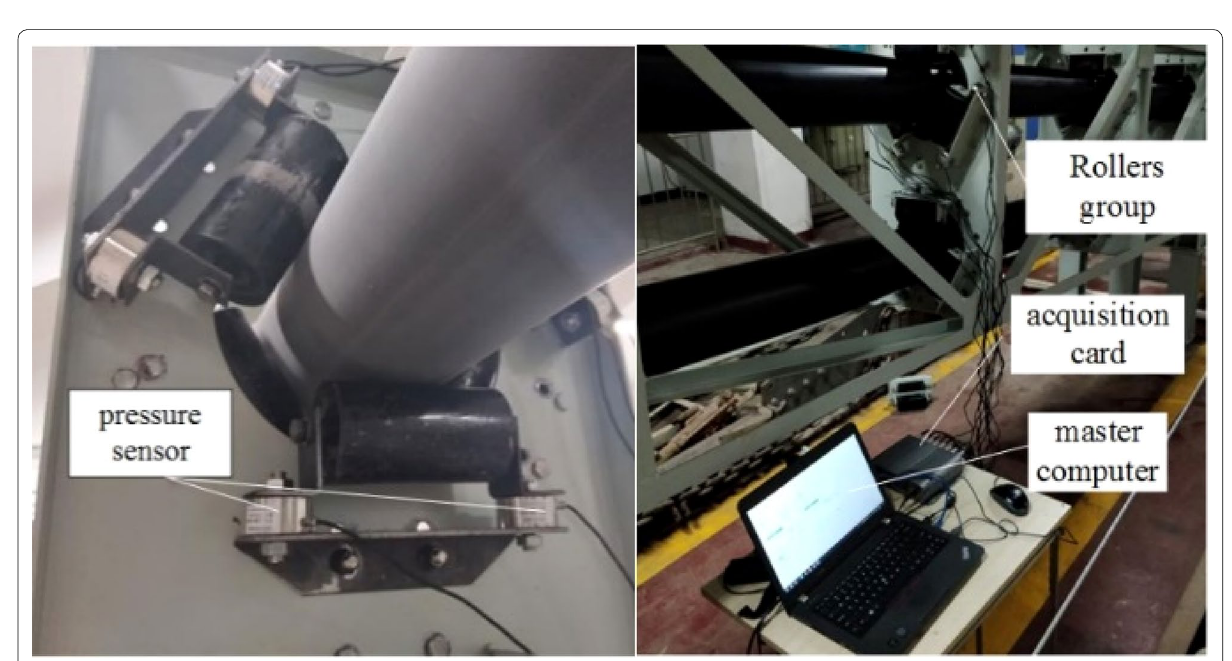
Figure 6 Test schematic of roller contact